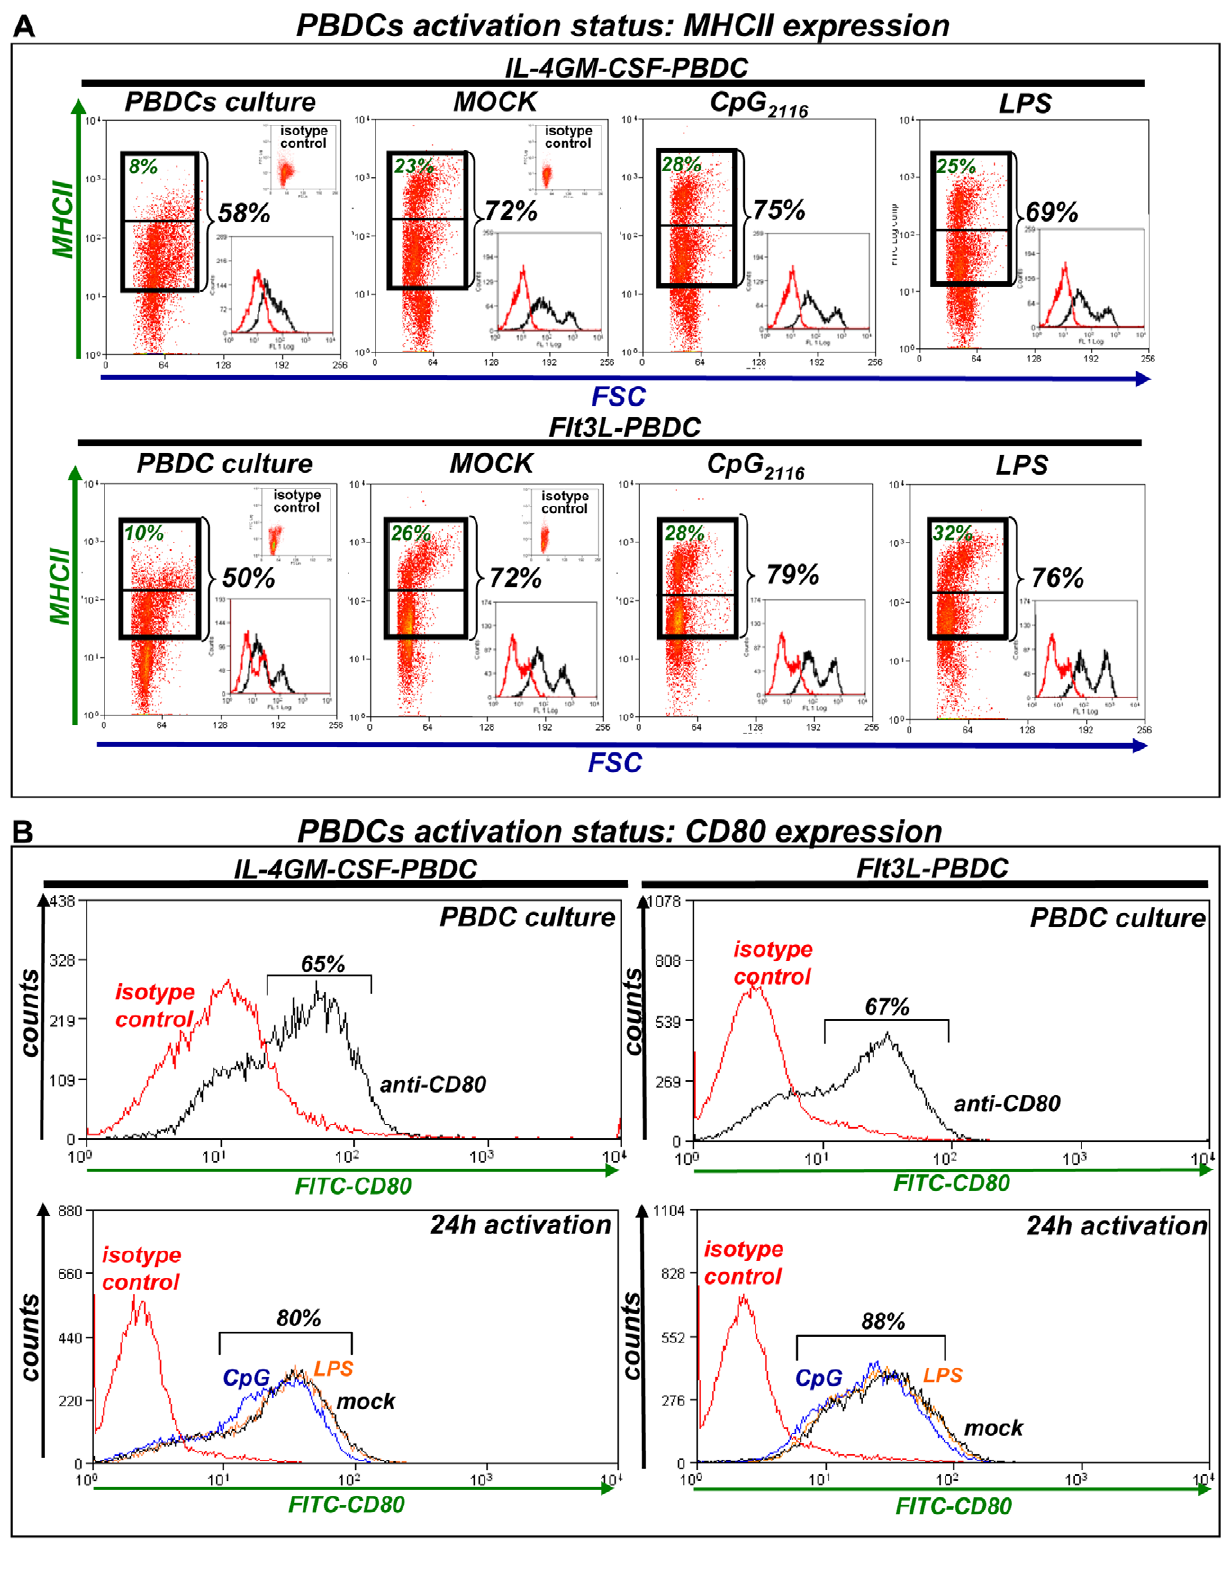
Figure 3. Activation status of dog peripheral blood DC cultures. Peripheral blood cultures were collected after 7 days in culture (PBDC culture). Cells were then incubated for additional 24 h without added cytokines in the absence (mock) or presence of CpG 2216 or LPS. Activation status was assessed by flow cytometry using an antibody against Major Histocompatibility Complex type II (MHCII, A ) or against the costimulatory marker CD80 ( B ). Black numbers in representative dot plots or histograms indicate the percentage of MHCII + or CD80 + cells. Green numbers indicate MHCII high cells. Insets on the top right show the dot plot of cells incubated with isotype control mouse IgG1. Insets on the bottom right show